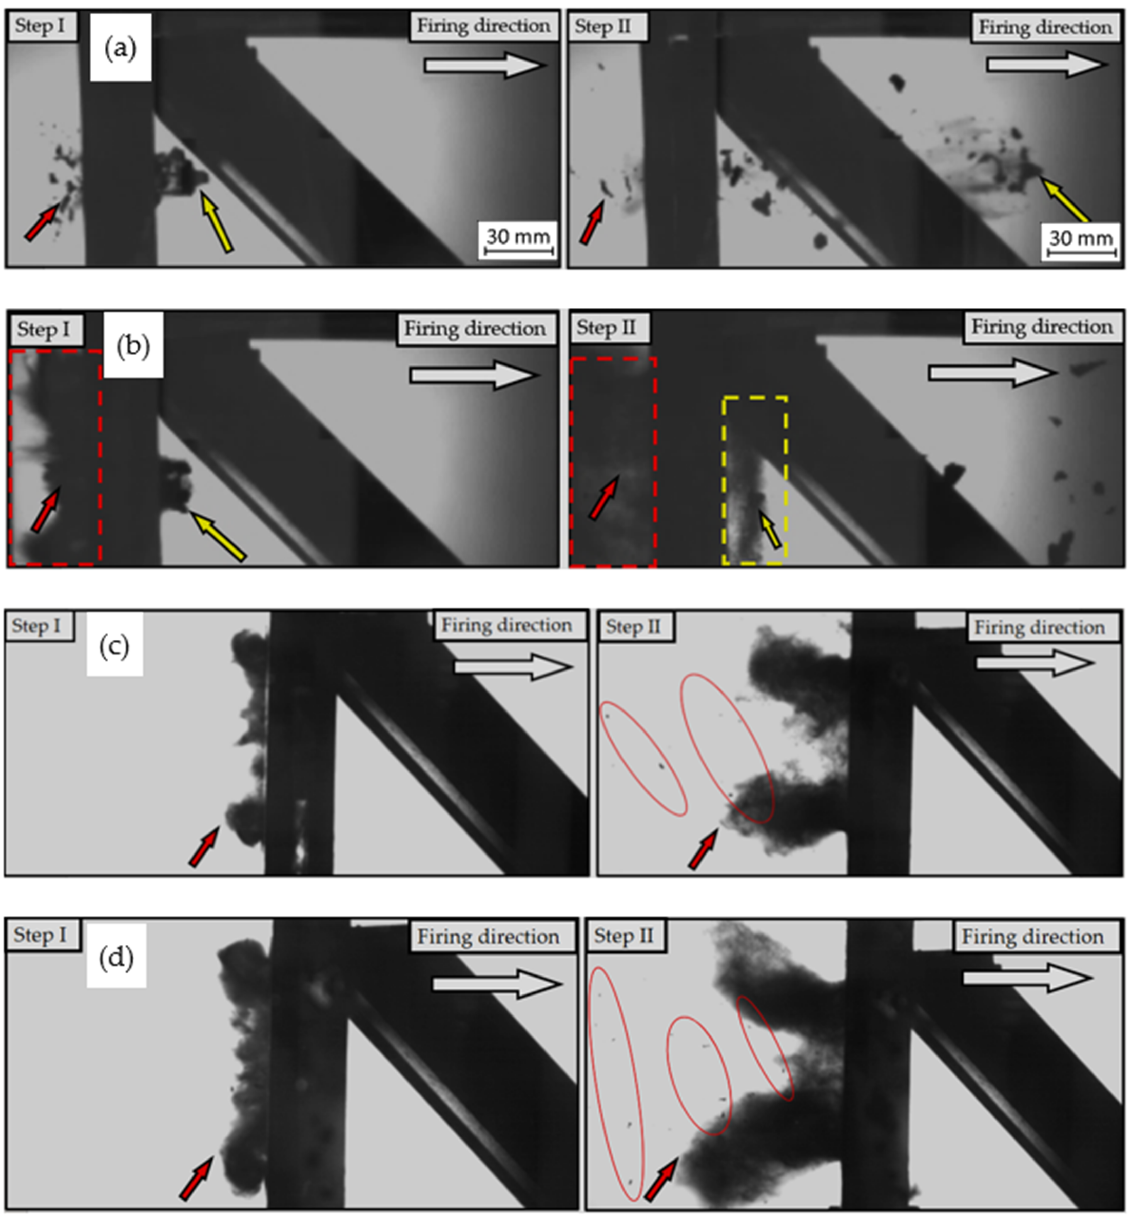
Figure 12. High ‐ speed camera images captured during plates perforation: ( a ) BHT condition, 936m/s impact velocity; ( b ) AHT condition, 918m/s impact velocity; ( c ) BHT condition, 746m/s impact velocity; ( d ) AHT condition, 743m/s impact velocity.